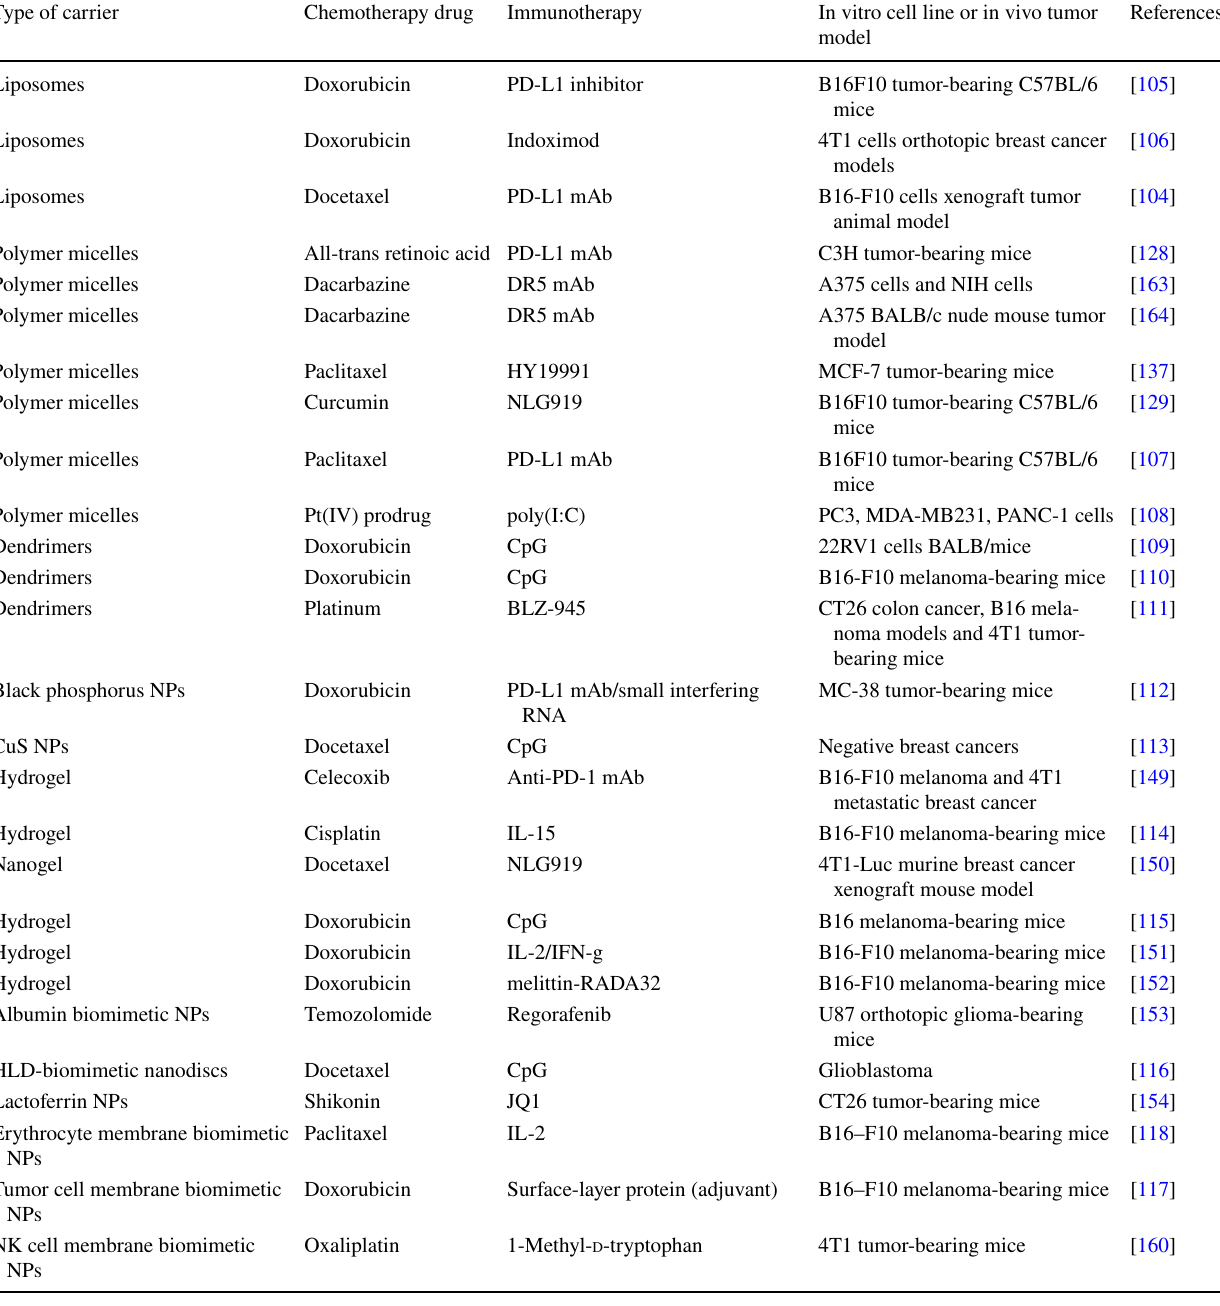
Table 4 Summary of NDDS for “co-encapsulation” approach in chemoimmunotherapy Type of